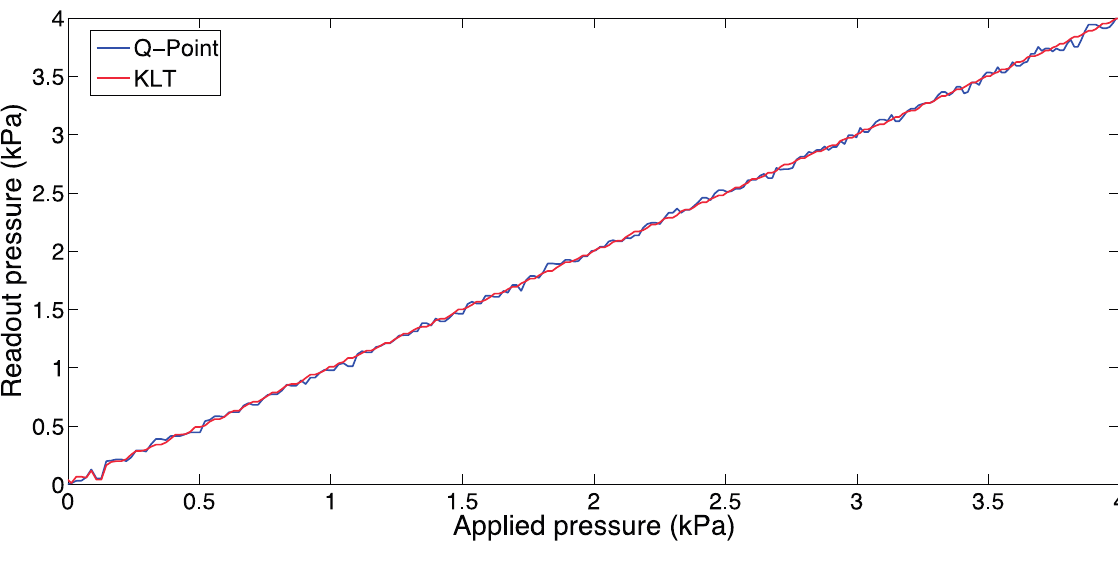
Figure 18. Experimental measurement of pressure with an EFPI, in a reference pressure chamber. The chart compares the pressure detected with Q-point tracking, and the KLT